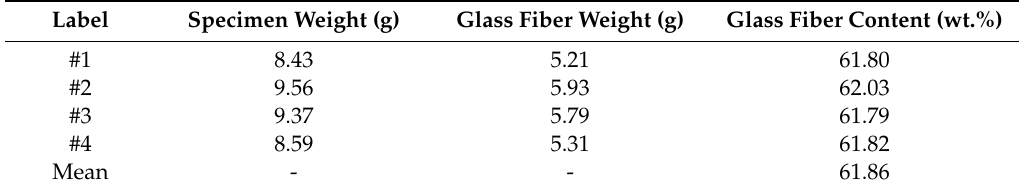
Table 10. Gc calculation result obtained from the burn-off method (design Gc 64%).